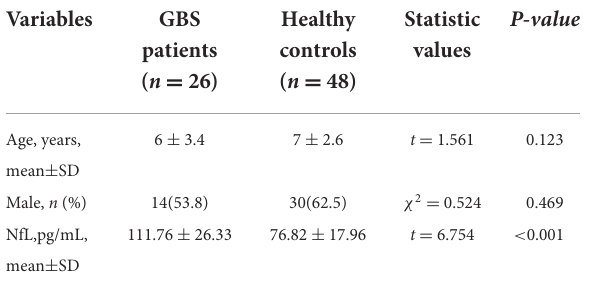
TABLE 1 CSF-NfL in patients with GBS upon admission and healthy controls.